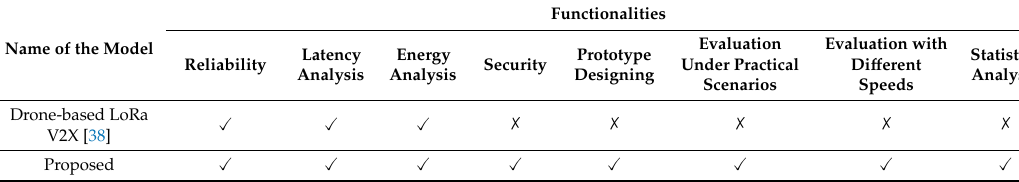
Table 9. Cont. Table 9. Comparison of the proposed architecture with state-of-the art LoRa V2X models. Table 9. Comparison of the proposed architecture with state-of-the art LoRa V2X models. Table 9. Comparison of the proposed architecture with state-of-the art LoRa V2X models. Table 9. Comparison of the proposed architecture with state-of-the art LoRa V2X models. Table 9. Comparison of the proposed architecture with state-of-the art LoRa V2X